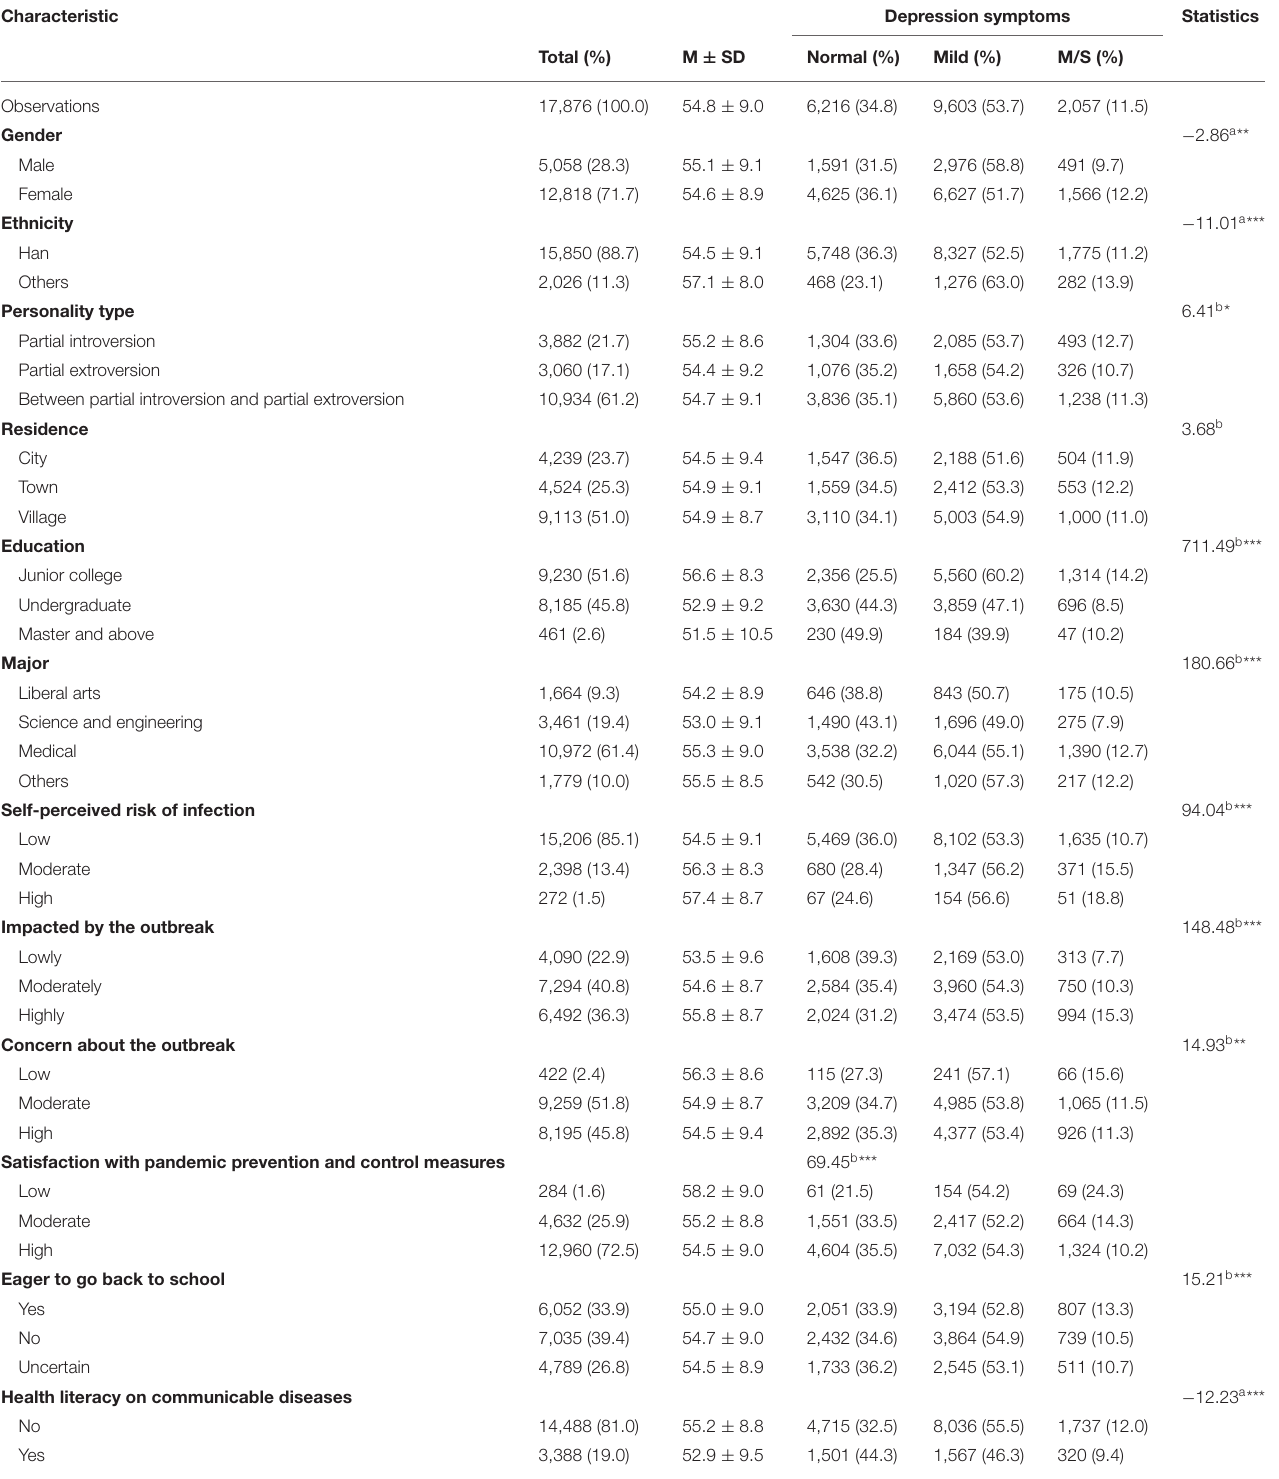
TABLE 1 | Demographic characteristics of the university and college students by self-reported depression status.